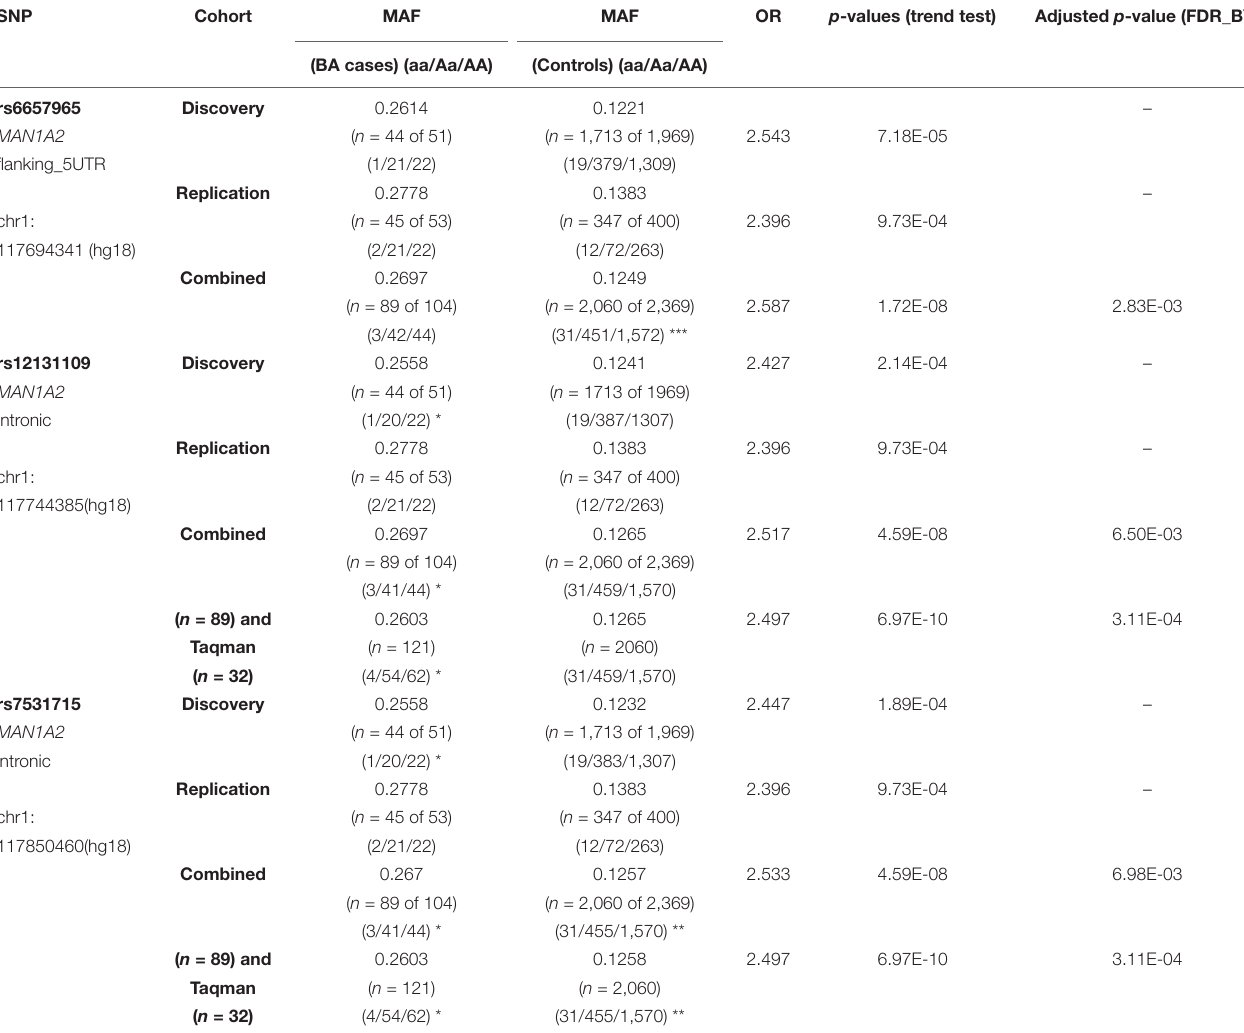
TABLE 1 | SNPs associated with